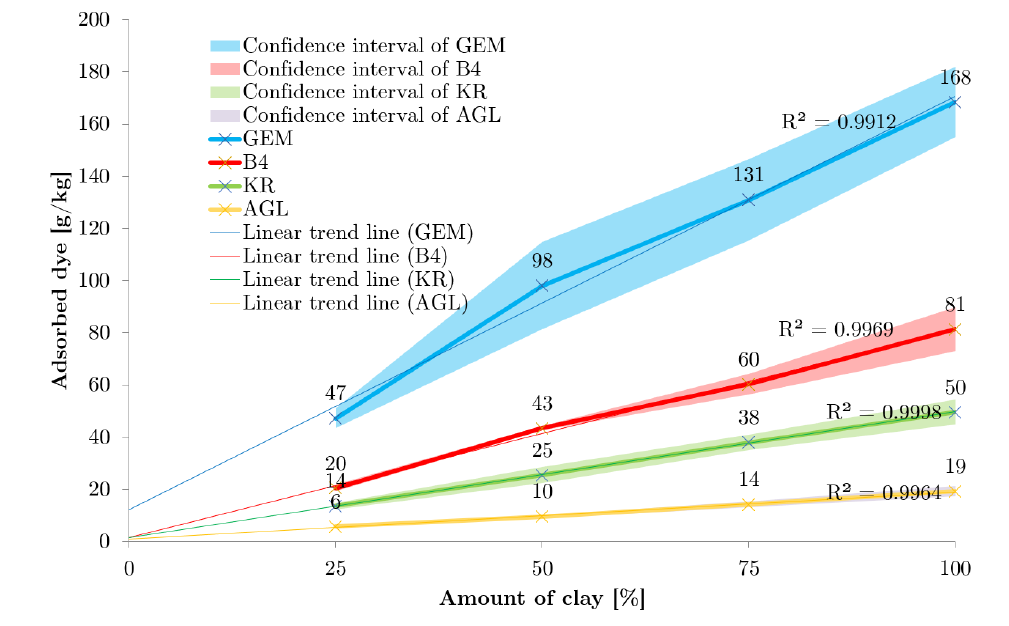
Figure 10. Confidence intervals for obtained values of adsorption